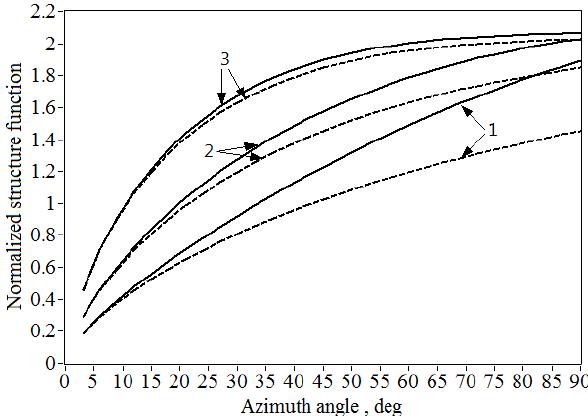
Figure 1. Normalized structure functions D r (ψ)/σ 2 r (solid curves) and D ⊥ (R (cid:48) ψ)/σ 2 r (dashed curves) calculated, respectively, by Eqs. (7) and (8) with the use of the model (Eq. 9) at R (cid:48) /L V = 0.5 (curves 1), 1 (curves 2), and 2 (curves